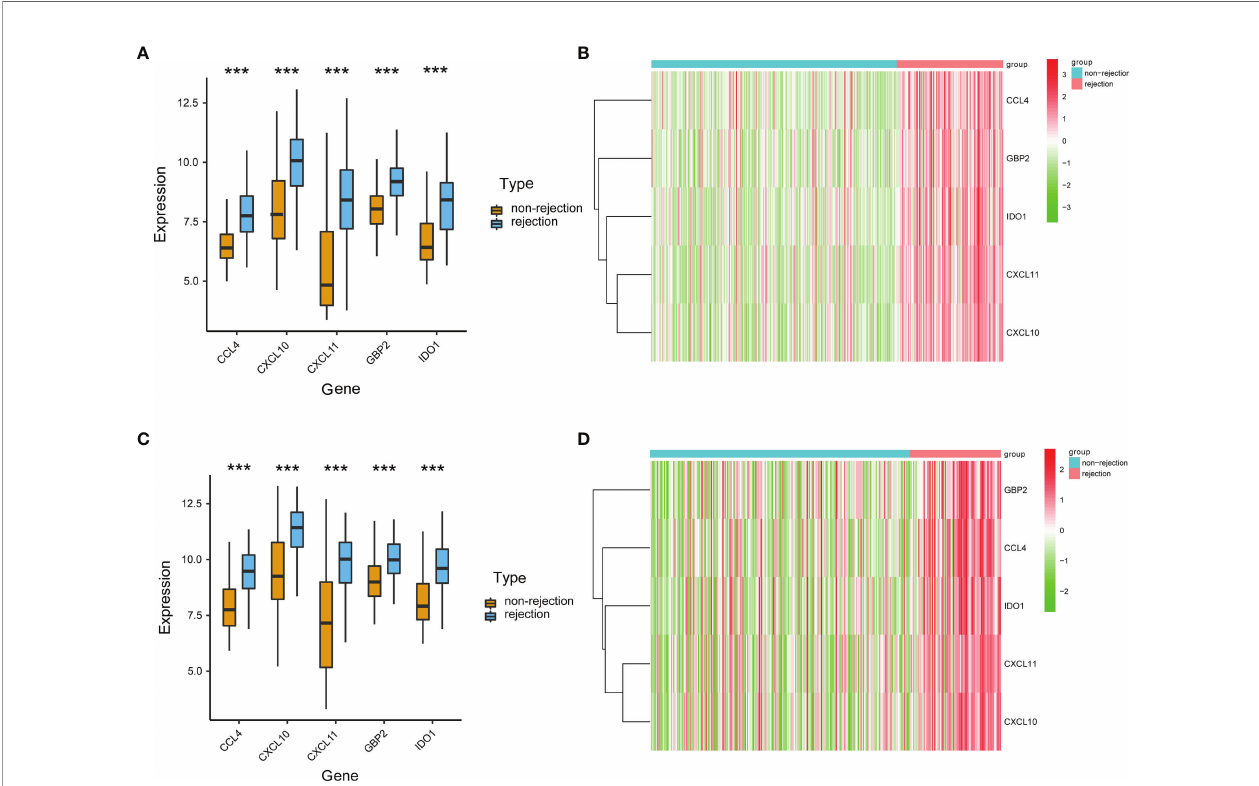
FIGURE 4 | Validation of the expression levels of identi fi ed immune-related genes. (A) The expression levels of the identi fi ed fi ve genes in the discovery cohort. (B) The heat map of identi fi ed genes in the discovery cohort. (C) The expression levels of the identi fi ed fi ve genes in the GSE48581 dataset. (D) The heat map of identi fi ed genes in the GSE48581 dataset. ***p <